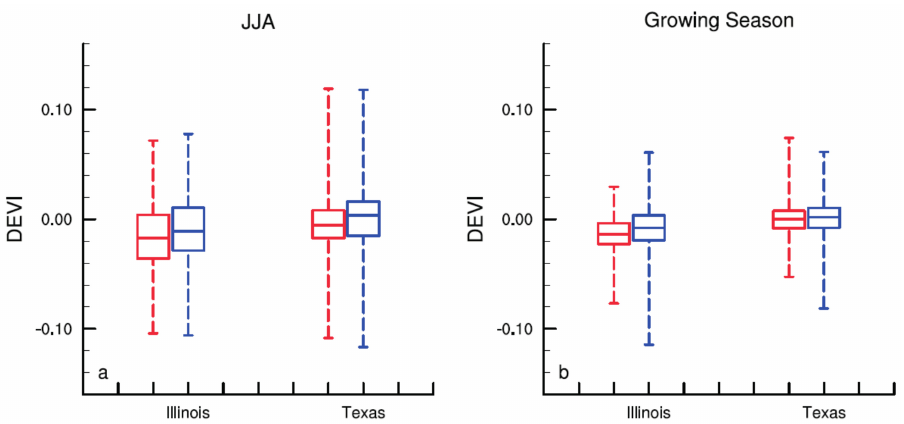
Figure 7. Box-and-whisker diagrams of DEVI (2010–2014 averages minus 2003–2004 averages) over WFP and NWFPs in Illinois and Texas, respectively: ( a ) DEVI in JJA, ( b ) DEVI during the growing season. Each box is used to depict DEVI from WFPs (in red) and NWFPs (in blue) through their five values: the minimum, 25th percentile, median, 75th percentile, and maximum. The bottom and top of the box are the 25th and 75th percentile (the lower and upper quartiles, respectively), and the horizontal line within the box is the median. WFPs and NWFPs are defined as in Figure S2.